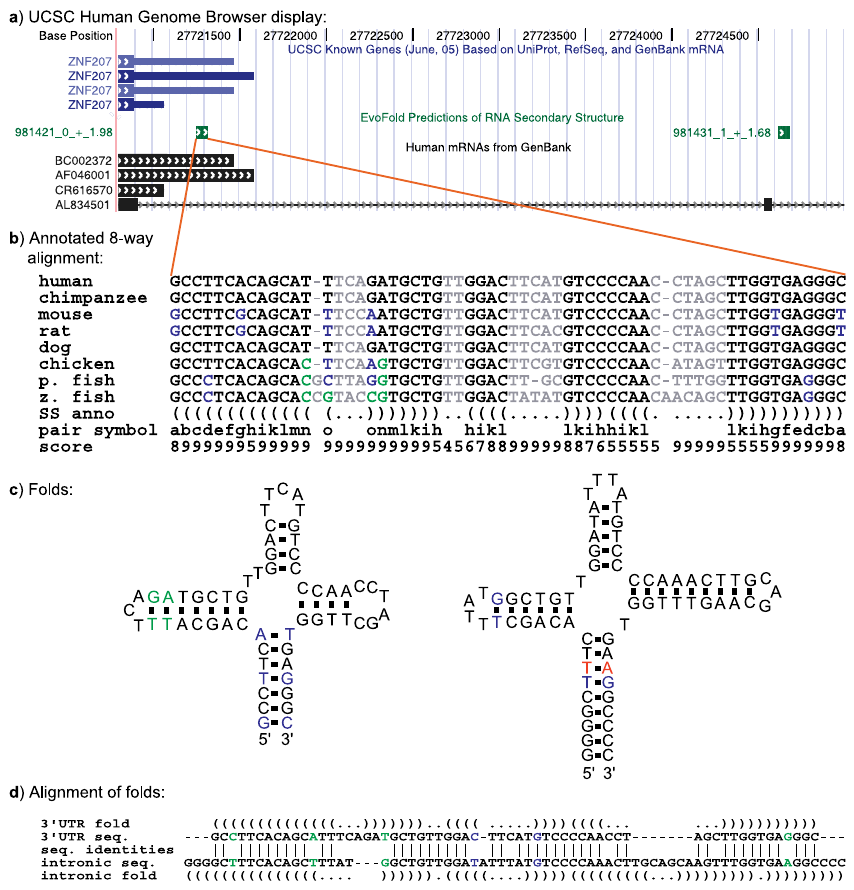
Figure 6. Clover-Shaped Fold Predictions (A) Gene structure, EvoFold predictions, and cDNAs around the end of the gene ZNF207 . The 3 9 UTR and the intron of an alternative splice variant harbor high-scoring clover-shaped fold predictions. (B) Annotated segment of eight-way alignment spanning the 3 9 UTR fold (see Figure 3B for legend). (C) Depictions of 3 9 UTR fold (left) and intronic fold (right). (D) Annotated alignment of human primary sequences of 3 9 UTR and intronic folds. The alignment is annotated with the secondary structures of the folds and substitution differences in corresponding pairs are color-coded (see Figure 3B for color